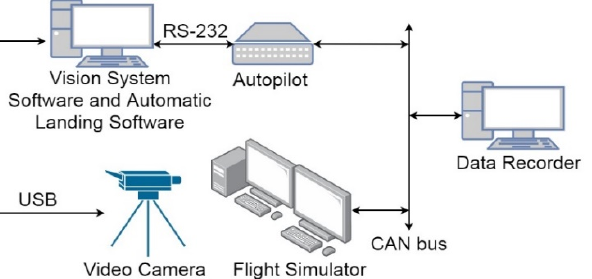
Figure 16. The configuration of the SIL laboratory stand used for investigating the picture-processing and control algorithms